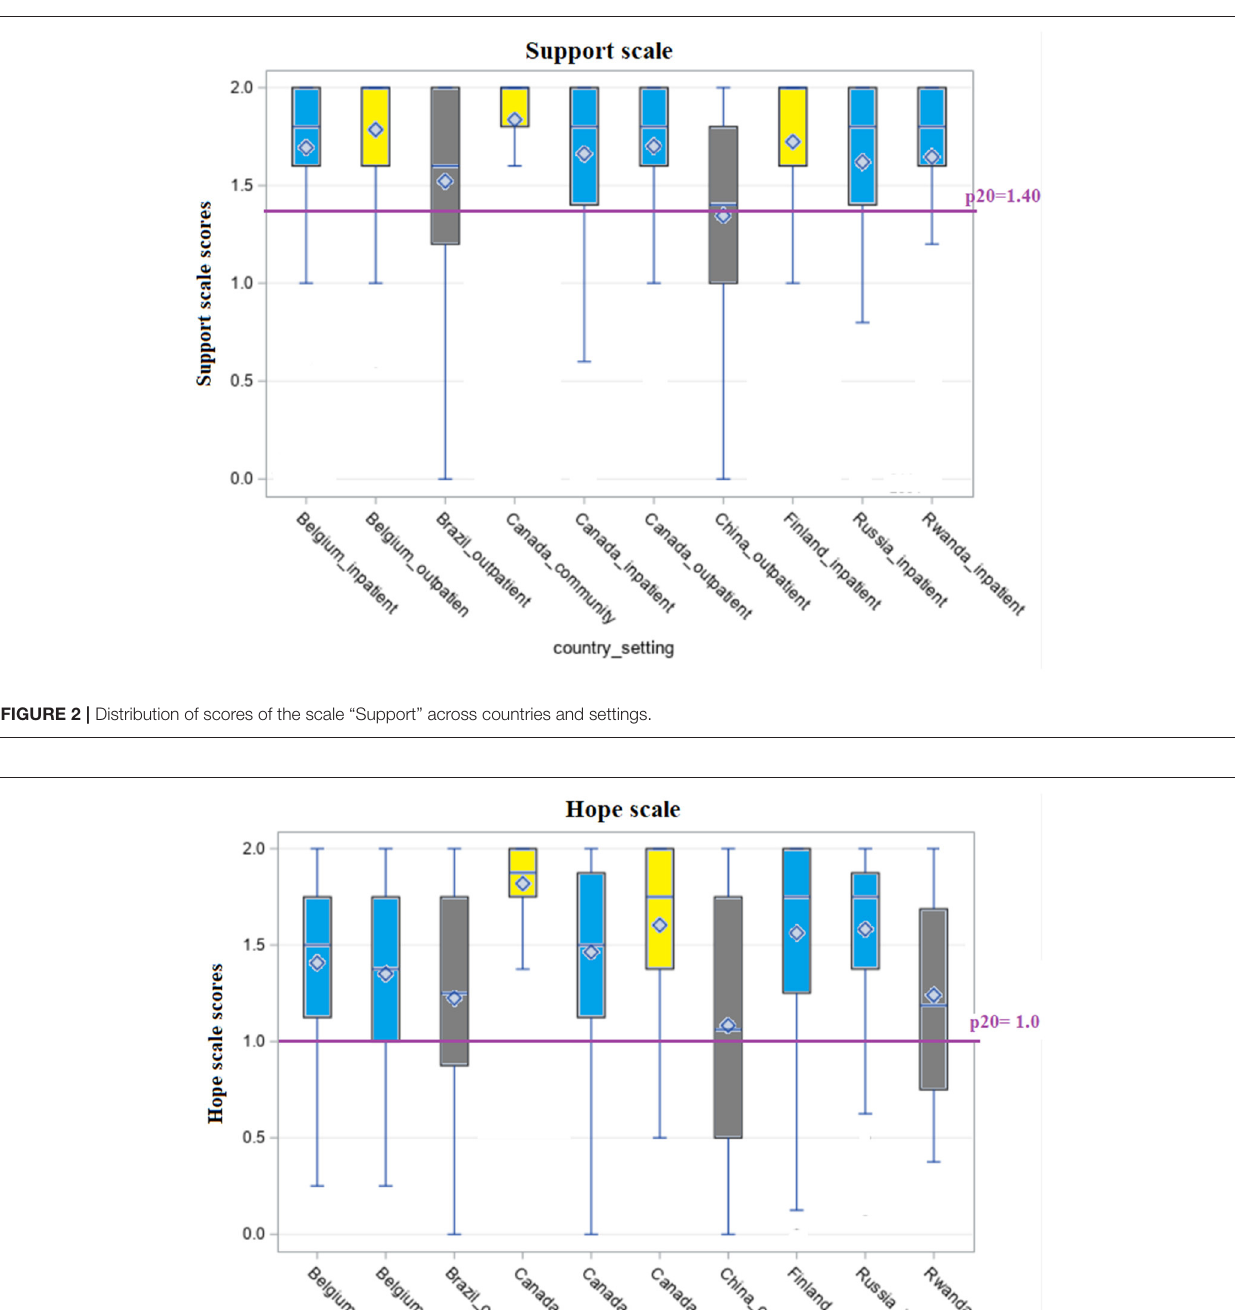
and 5%. The item about work and education opportunities was the only one with more missing values, with a total of 8.5% missing. The domain scales of the SQoL-MHA were in all